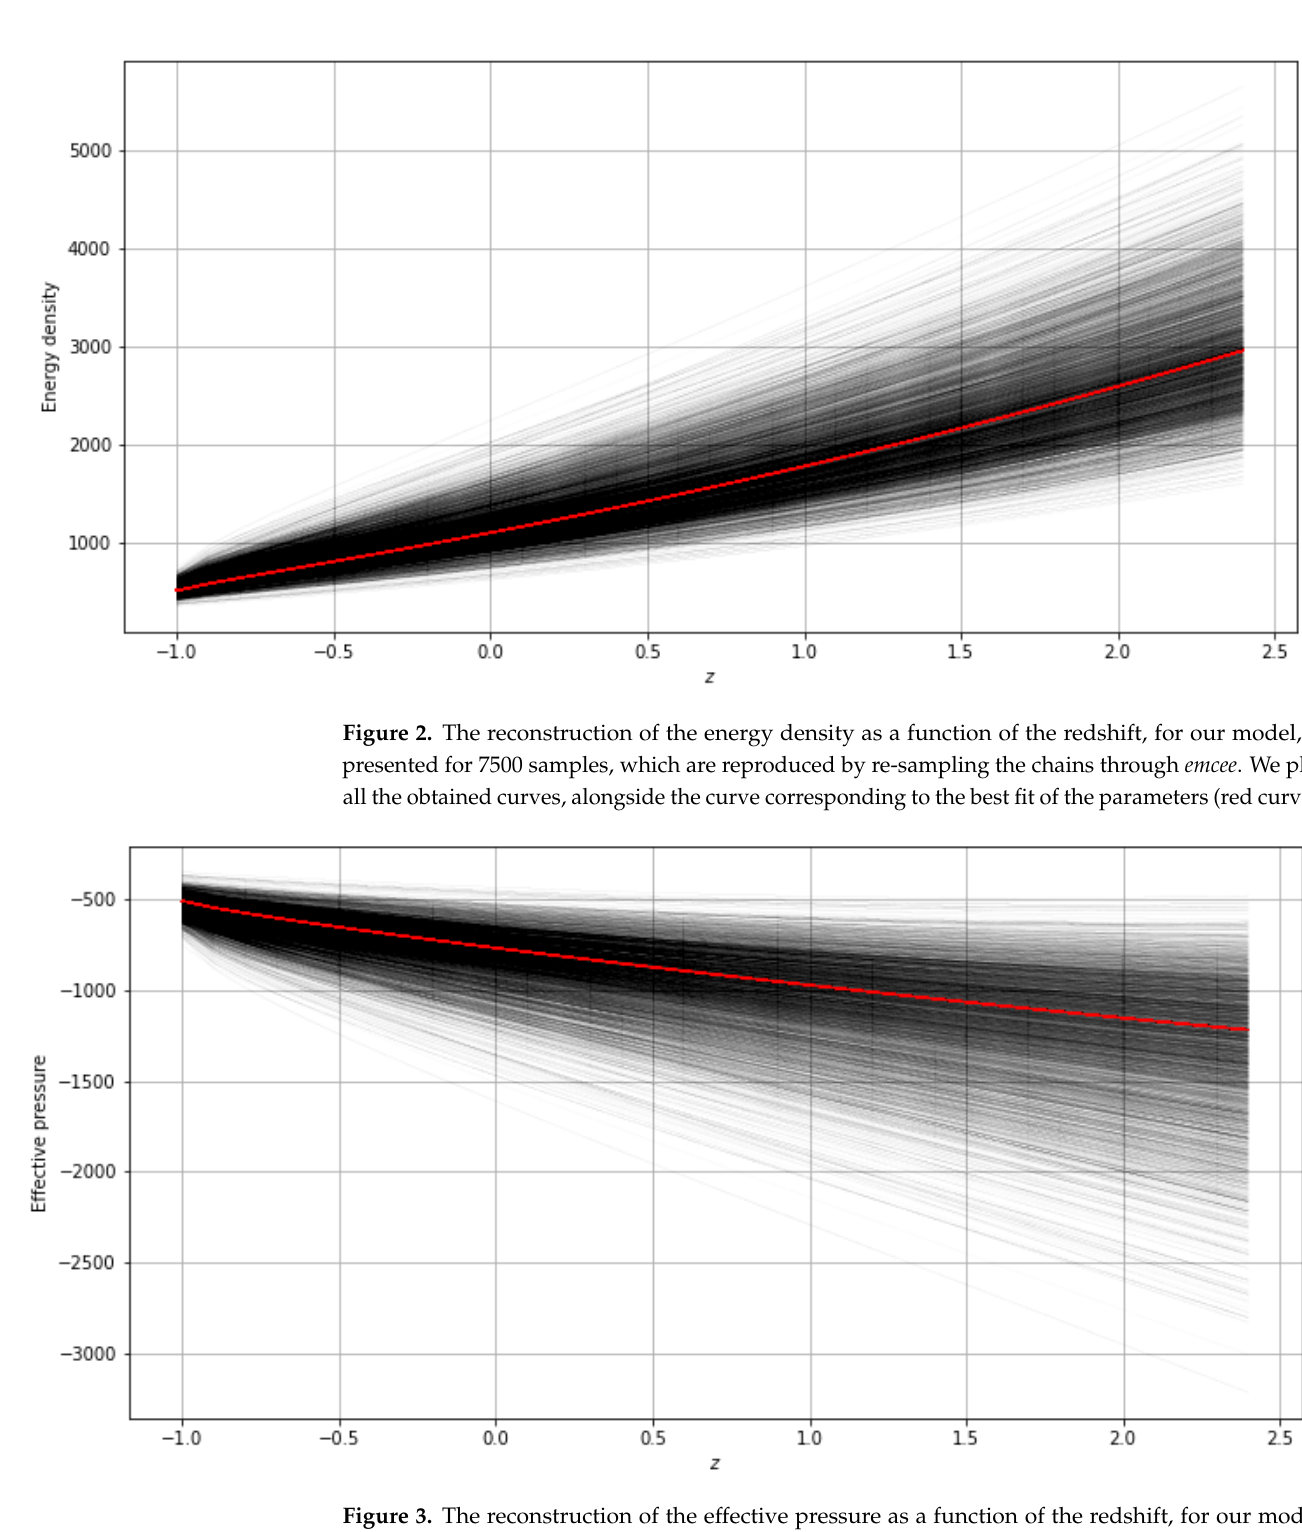
Figure 3. The reconstruction of the effective pressure as a function of the redshift, for our model, is presented for 7500 samples, which are reproduced by re-sampling the chains through emcee . We plot all the obtained curves, alongside the curve corresponding to the best fit of the parameters (red